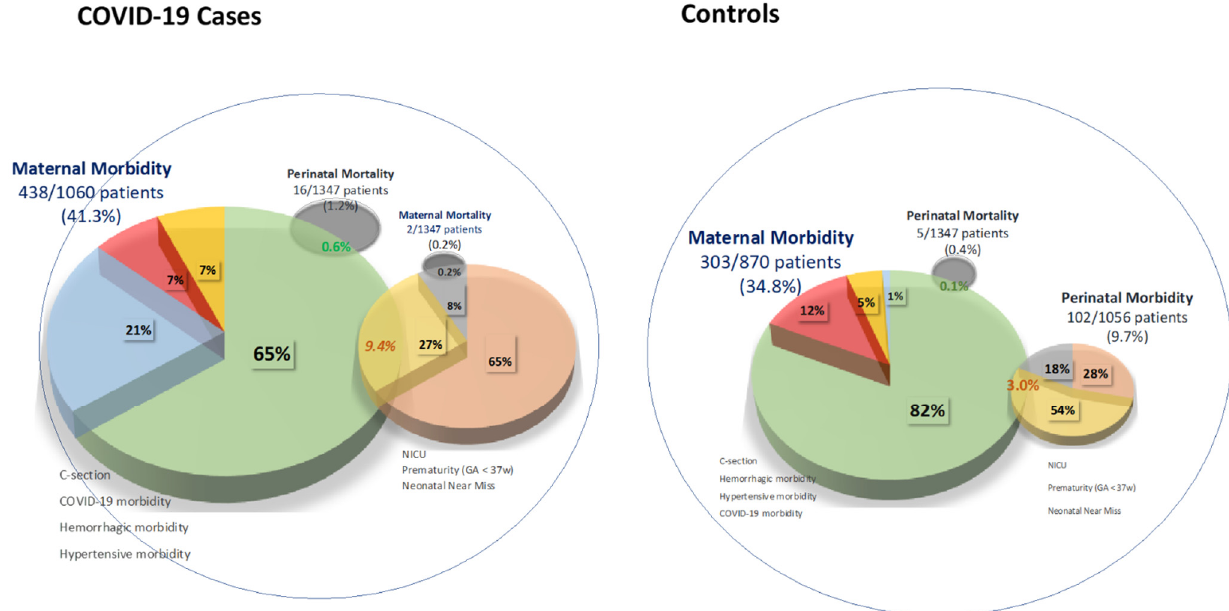
Figure 2. Maternal–perinatal morbidity and mortality and risk of loss of maternal–perinatal well-being by SARS-CoV-2 active infection status. In the figure, the proportionality of each entity over the whole number of cases and controls is conserved.